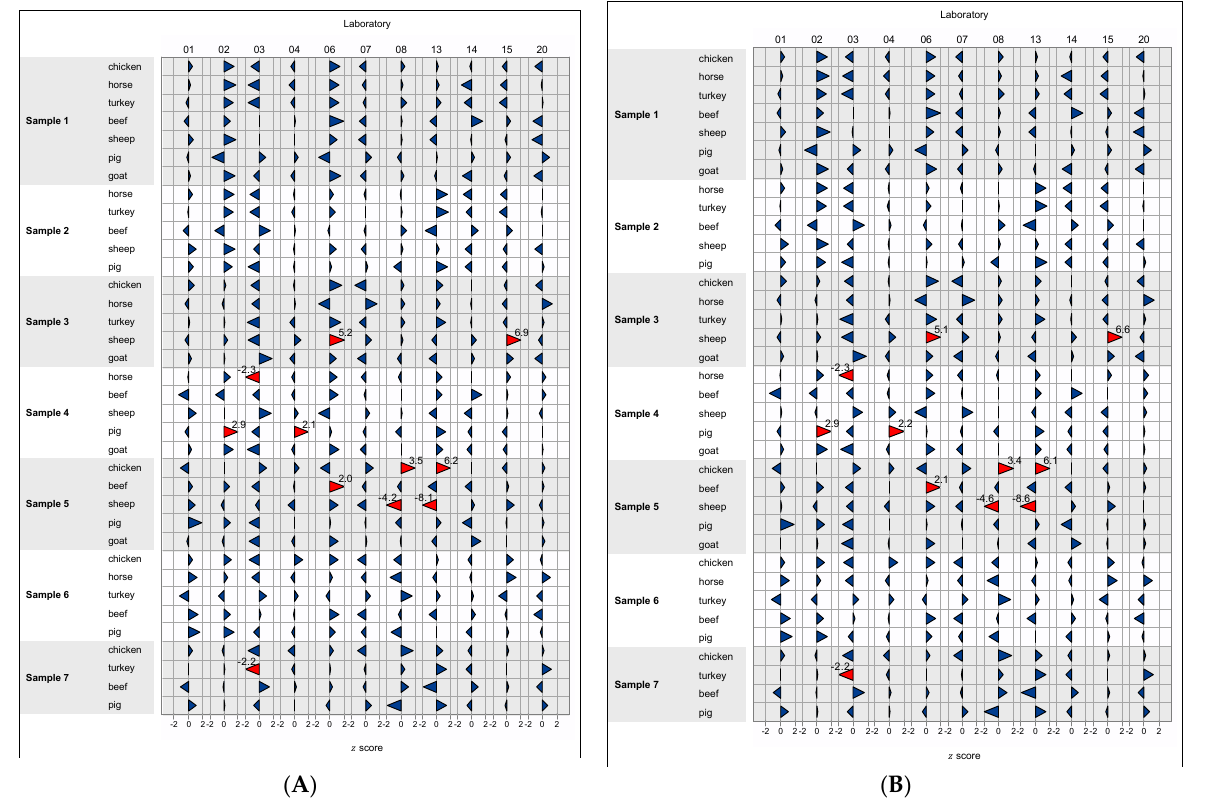
Figure 5. z scores for determination of proportions of animal species. ( A ) AGES database, ( B ) NCBI database. Absolute z scores < 2 are shown in blue, absolute z scores > 2 in red.